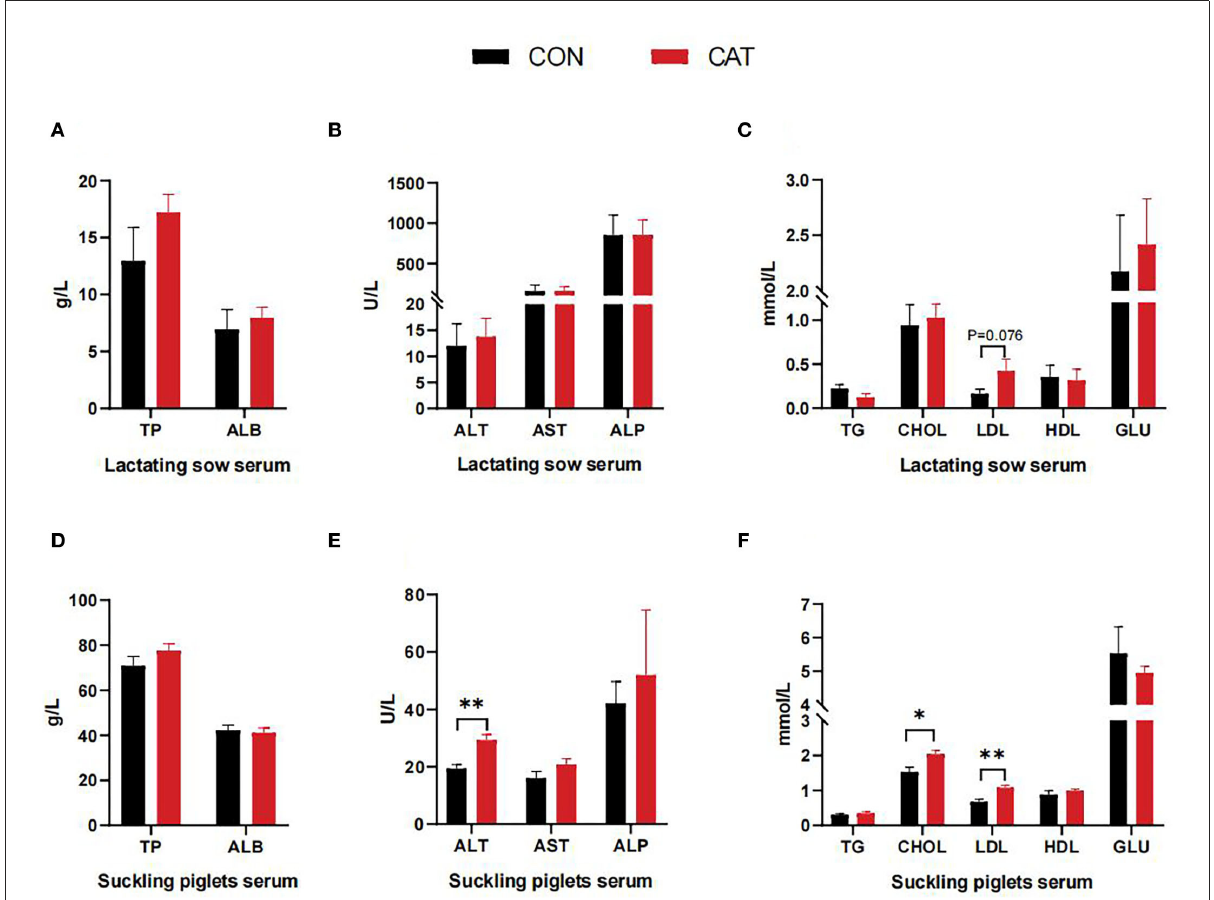
FIGURE1 (A–F) Serum biochemical indexes. Values are presented as mean ± SEM; n = 6, * and **indicate a statistically significant difference by t -test at P < 0.05 and P < 0.01,